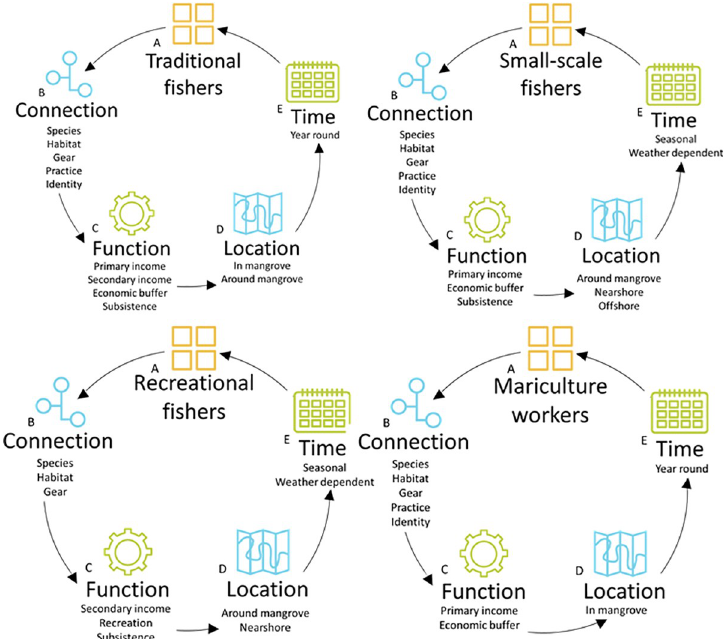
Fig 5. A typology of mangrove-fishing by the Benoa Fishing Community, by A) sector, through B) connection with the mangrove, C) function of fishing and D) location of fishing and E) time of mangrove-associated of fishing.